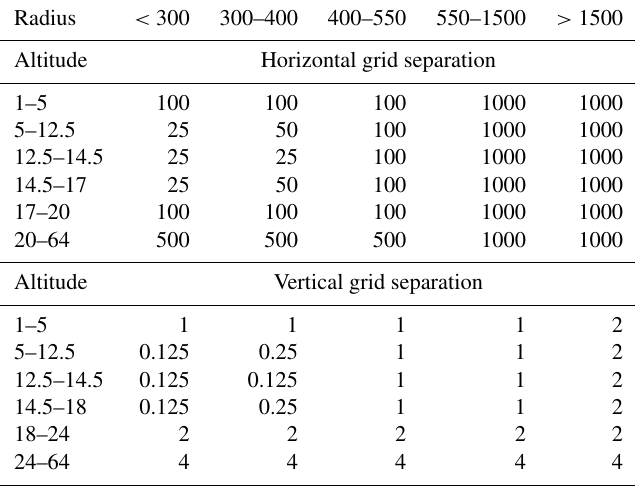
Table 2. Grid densities in different regions for retrieval D in